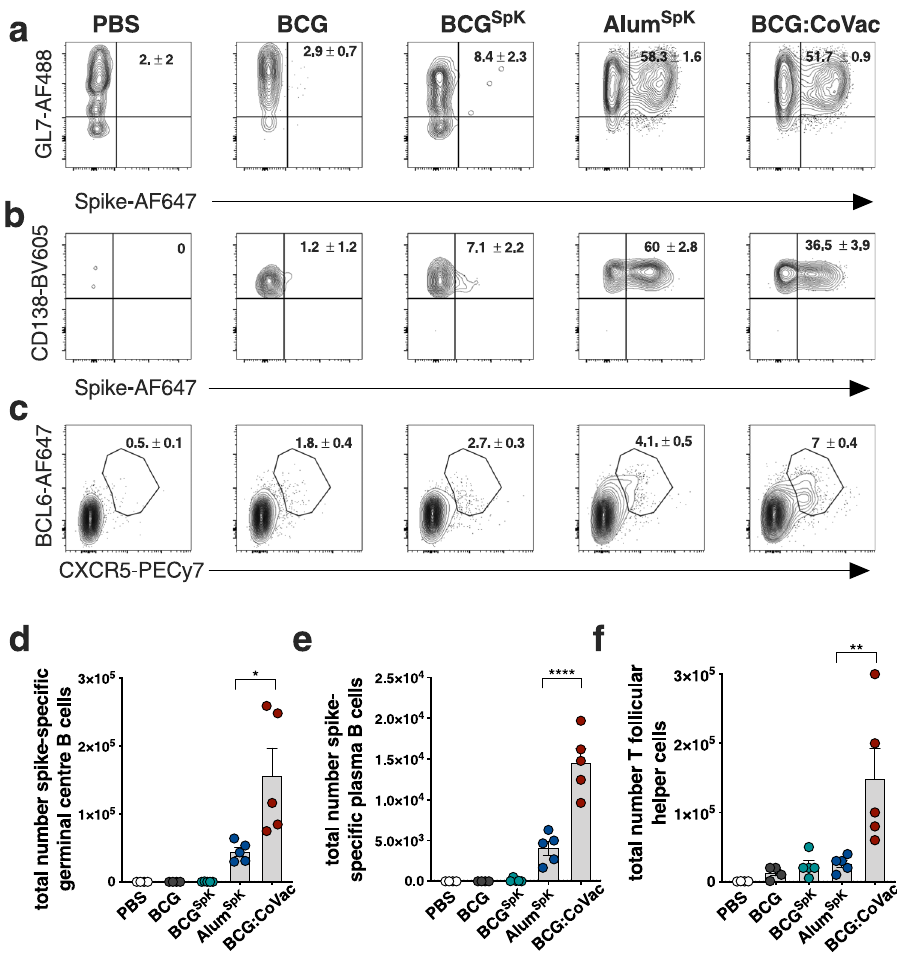
Fig. 2 BCG:CoVac vaccination promotes expansion of T follicular helper cells and spike-speci fi c B cells in mice. a – c C57BL/6 mice ( n = 5/ group) were vaccinated subcutaneously with PBS, BCG, BCG SpK , Alum SpK or BCG:CoVac and 7 days after immunisation B and T cell response assessed by multicolour fl ow cytometry in the draining lymph node. Shown are representative dot plots of spike-speci fi c germinal centre B cells ( a , CD19 + MHCII + GL7 + CD38 − ), plasma B cells ( b , CD19 + MHCII + CD138 + ) and T follicular helper T cells ( c , CXCR5 + BCL6 + ) with average ±SEM (gating strategy in Supplementary Figs. 4 and 5). d – f The total number of d spike + GC B cells, e spike + plasma cells and f T follicular helper cells. Data presented as mean ± SEM and is representative of two independent experiments. Signi fi cant differences between